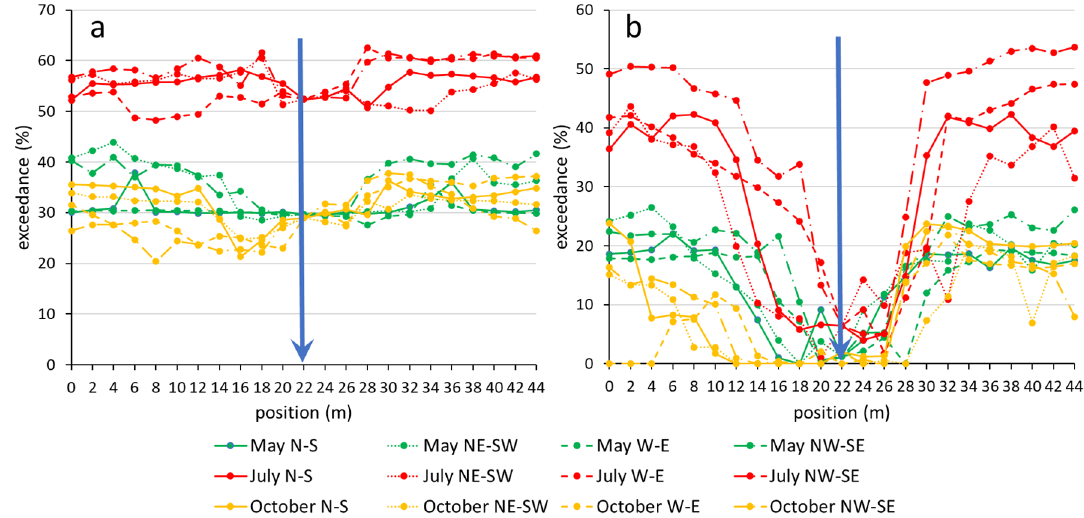
Figure 4. Exceedance (duration) (%) for VPD values above 1.2 kPa ( a ) and VPD values above 3.0 kPa ( b ) from 24-hour period of three measurement periods; the left sides of the positions are the “cold” ends (W, NW, N, and NE), the right sides are the “warm” ends (E, SE, S, and SW), and the blue arrows are the centres of the transects.